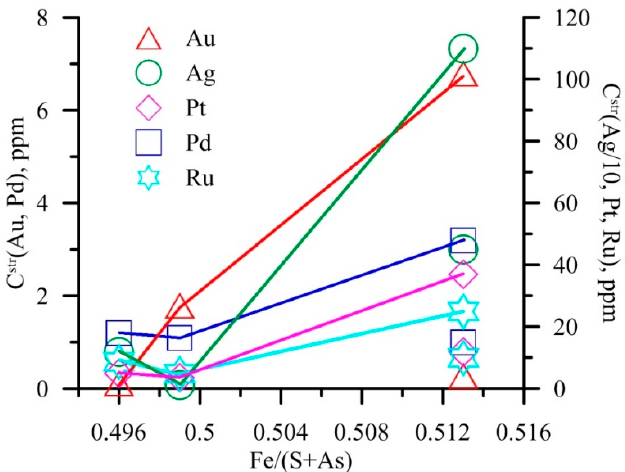
Figure 13. Structurally bound NMs as a function of the stoichiometric ratio in As–pyrite crystals. Note the ten-fold reduced concentration scale for Ag. See Tables 2 and 4 for numerical data.